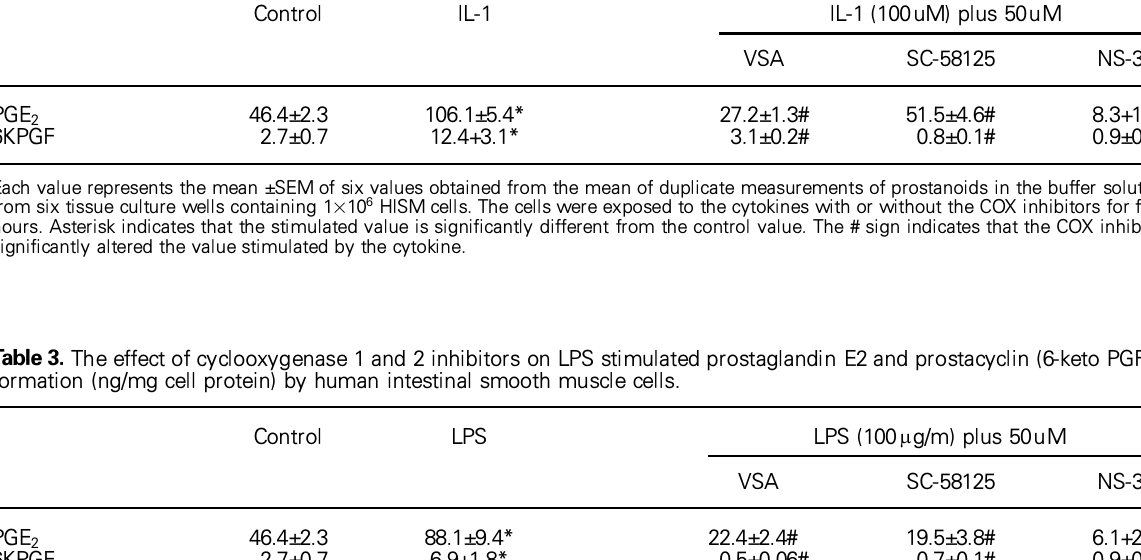
Symbols as for Table